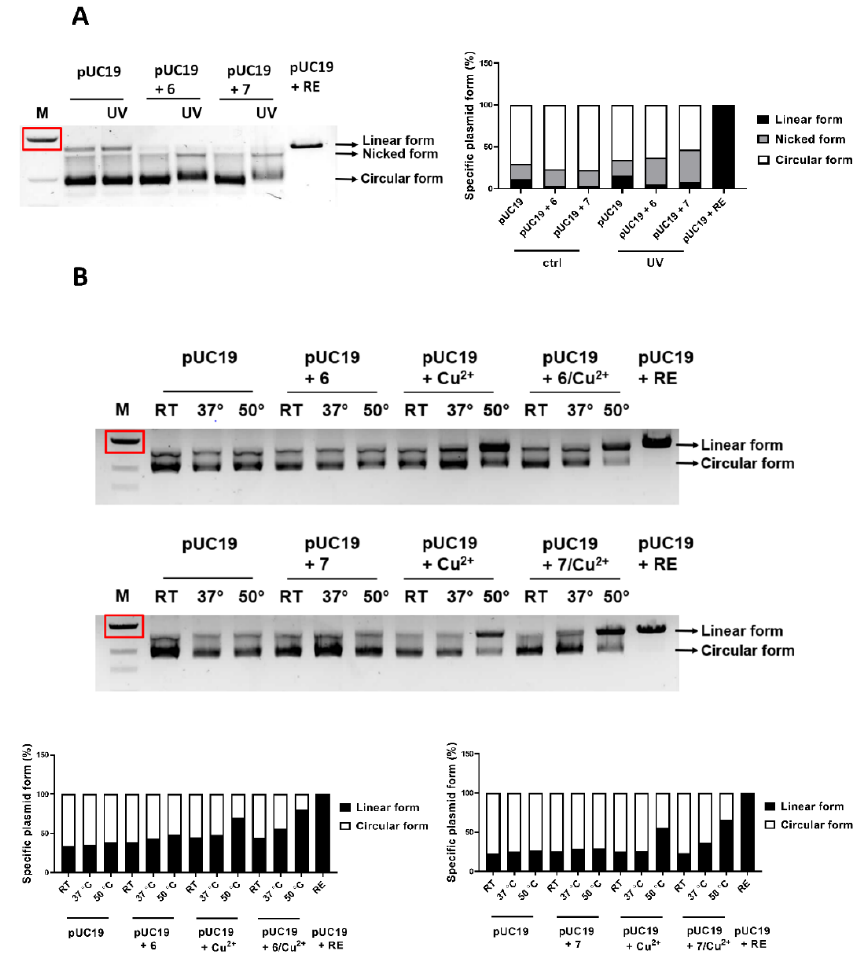
Figure 6. Representative agarose gel and quantitative analysis of supercoiled pUC19 (2686 bp) plas- mid DNA incubated with 6 and 7, with or without ( A ) exposure to UV light (30 sec) or ( B ) presence of the Cu 2+ cation at various temperatures (room temperature, 37 or 50 ◦ C) for 24h. For ( A ) assay, 30 µ M of the tested compound was incubated with 1 µ g of pUC19, while for ( B ) assay, 10 µ M of 6 , 7 and the complexes 6 /Cu 2+ or 7 /Cu 2+ were incubated with 1 µ g of pUC19. A plasmid without compounds, a plasmid with only a Cu 2+ cation and a plasmid linearized with restriction enzyme (RE) served as controls. M—GelPilot DNA Molecular Weight Marker 1kb (Qiagen, Germantown, MD, USA). The red rectangle represents a DNA fragment of 3000 bp. Quantitative analysis of specific plasmid forms was performed in ImageJ software 1.53e. Each form is presented as the percentage of total pUC19 forms per condition (white, grey and black columns). Graphs were constructed in GraphPad Prism 8. Representative data of three independent experiments which yielded similar results are